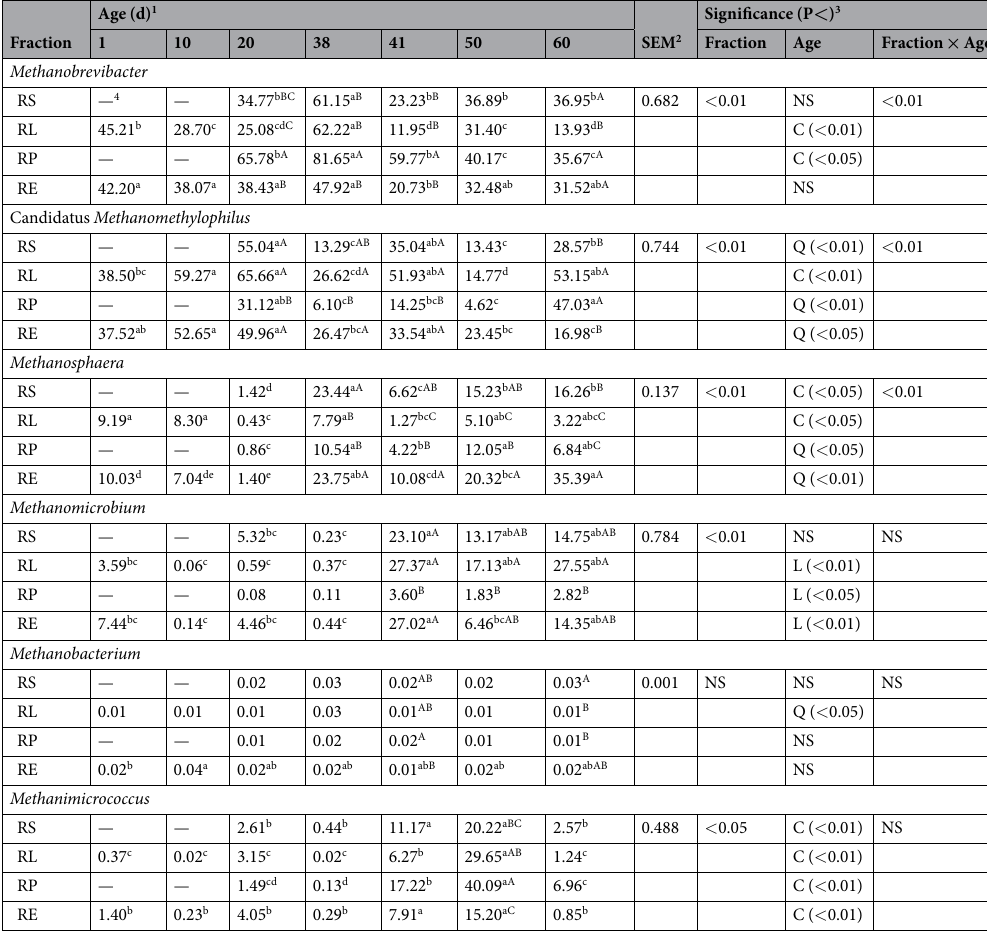
Table 2. Change of relative abundance (%) of active methanogenic genera in four fractions during rumen development a–e . Means within a row for days that do not have a common superscript differ (P < 0.05); A–C Means within a column for fractions that do not have a common superscript differ (P < 0.05). 1 Samples on 50 d and 60 d were collected from goats fed the control diet; SEM 2 represents SEM for fraction × age; 3 NS = not significant (P > 0.05), L = Linear effect of age, Q = Quadratic effect of age, C = Cubic effect of age; 4 No data due to the absence of